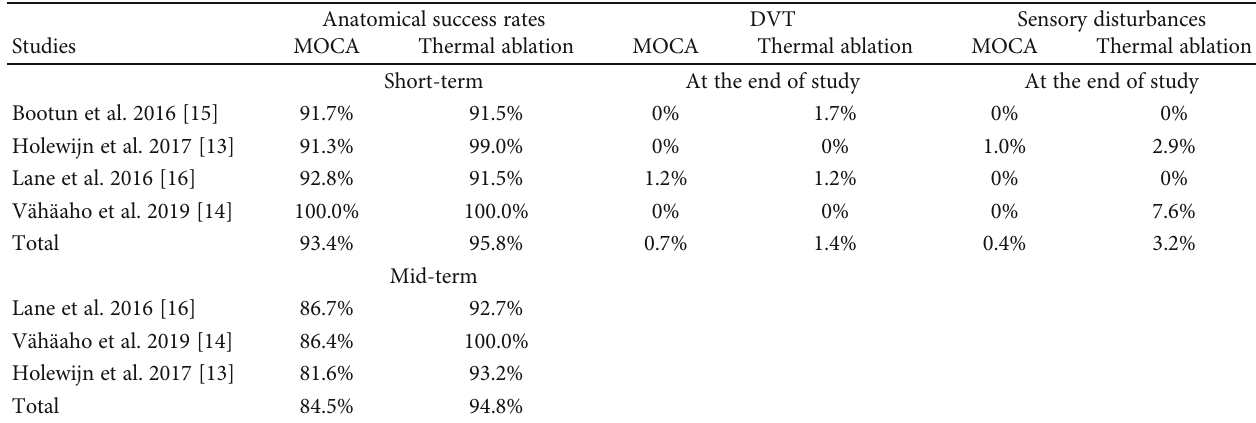
Table 4: Anatomical success and complication rates in each study.